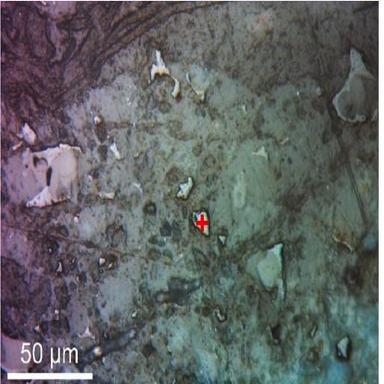
Raman spectra of (a) C4AF and (c) β-C2S identified in cracks (red cross) shown in optical micrographs (b and d) from samples with 0% CA and 1% CA,